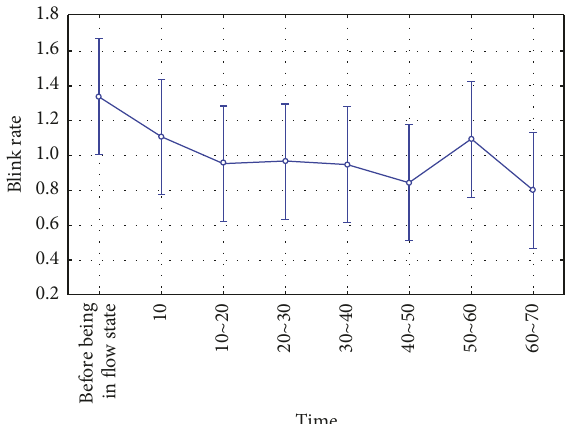
Figure 6: Blink rate result of nonflow group.